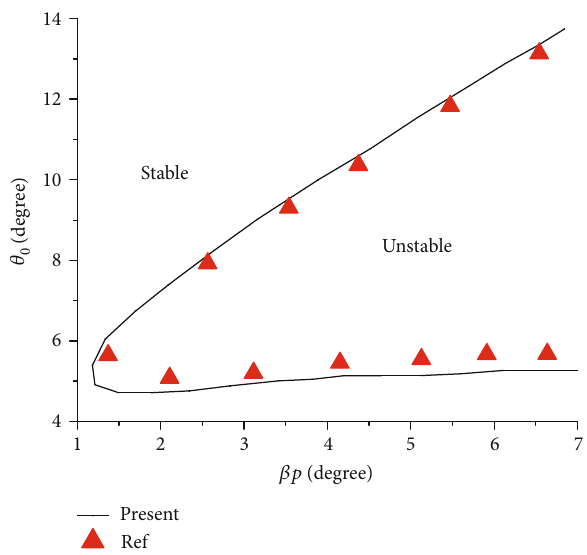
Figure 2: E ff ect of precone on the stability boundaries ( ω